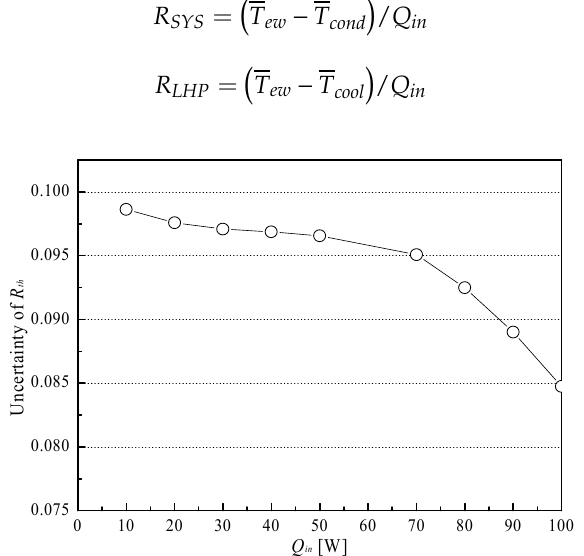
Figure 3. Uncertainty of the thermal resistance in the LHP